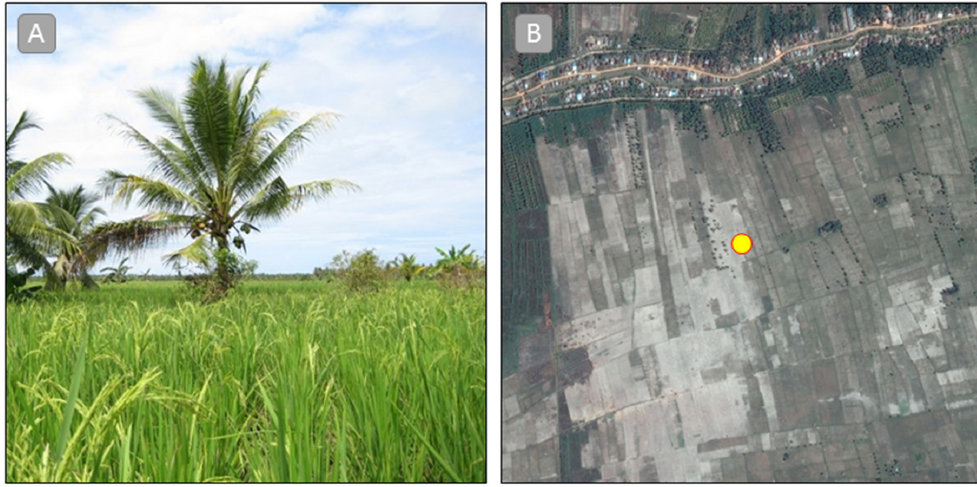
Figure 4. Geofield photo ( A ) of rice agricultural site near Singkawang, West Kalimantan ( B ).